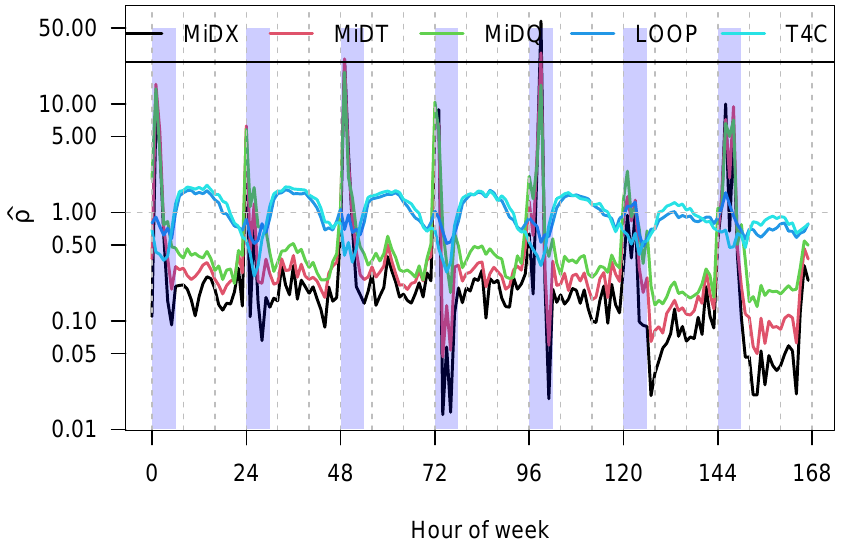
Figure 14. Risk index ρ as a function of the hour of the week for the five different exposure variables. The blue rectangles indicate the hours between 0 a.m. and 6 a.m.